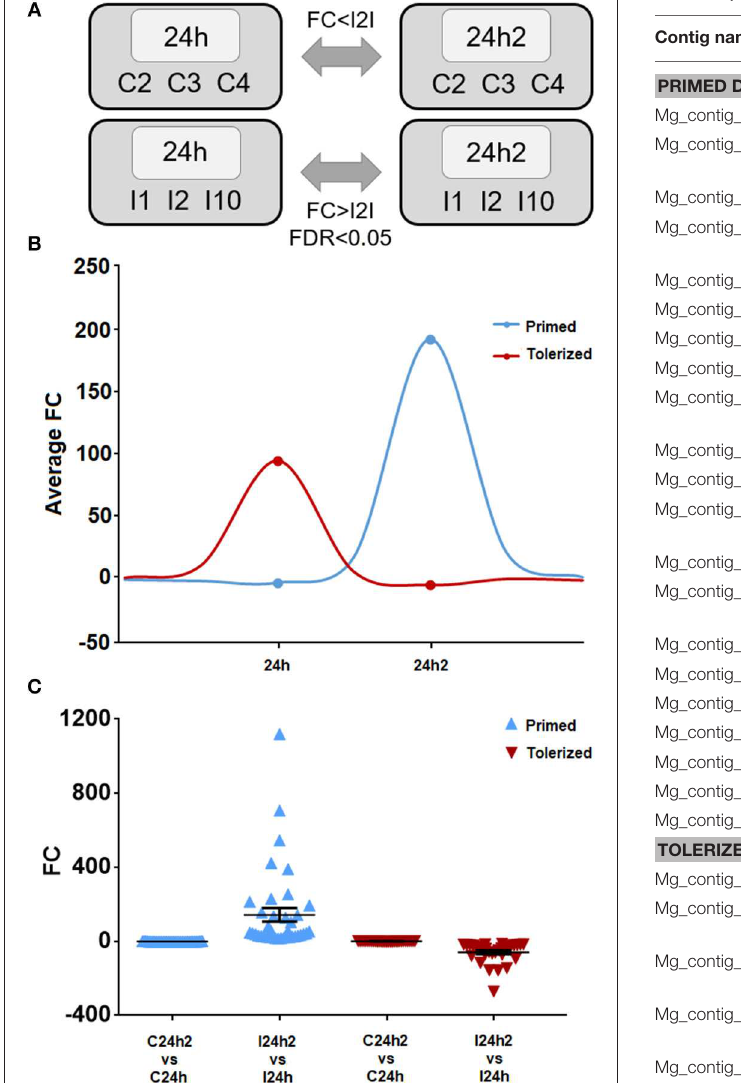
TABLE 3 | Identified primed and tolerized